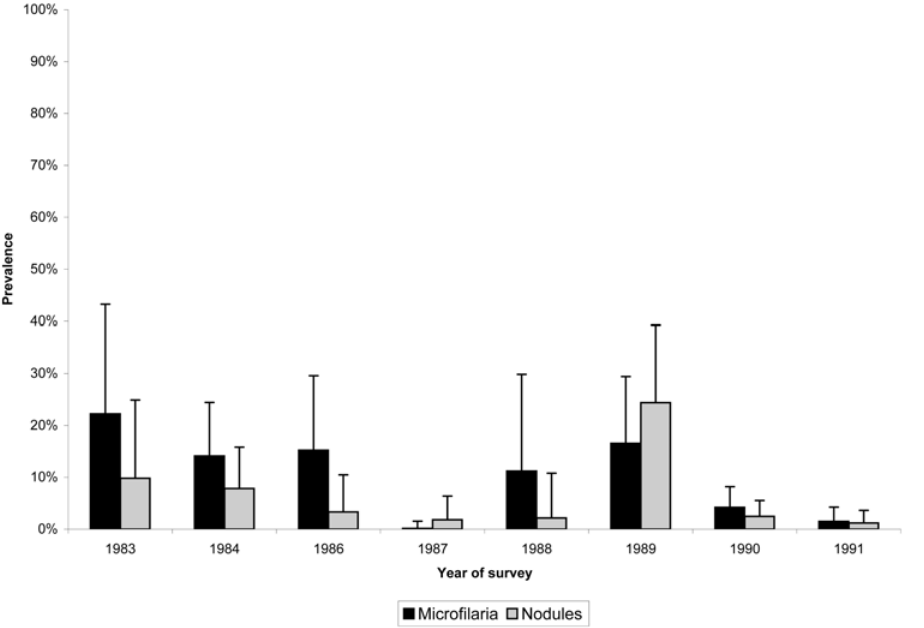
Figure 4. Mean community prevalence of microfilaria in the skin and nodules in the Escuintla-Guatemala focus. Unpublished Ministry of Public Health surveys from 1983 to 1991. Bars indicate the upper 95% confidence interval of the prevalence.